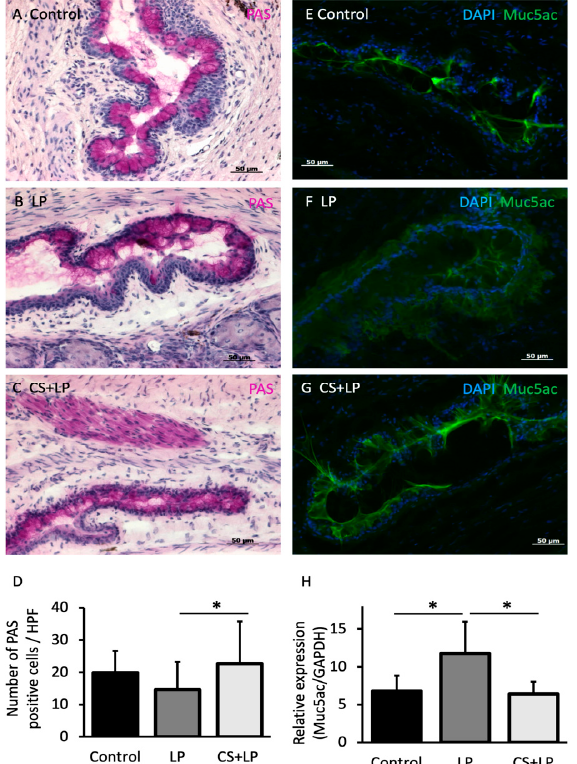
Figure 3. Conjunctival goblet cell periodic acid–Schiff (PAS) staining, muc5 immunohistochemistry staining, goblet cell density, and real time RT-PCR conjunctival muc5 mRNA expression comparisons. ( A – C ) Note the abundance of plump oval pink-purple goblet cells in the conjunctival epithelium in Group 1 (no treatment group) and Group 3, and the comparably scarce PAS positive goblet cells in Group 2 (Latanoprost group). ( D ) Note the significantly lower mean goblet cell density in the LP group compared with the CS + LP group ( p < 0.01). ( E – G ) Note the intense staining for muc5 in the conjunctival epithelium in Group 1 (no treatment) and Group 3 (CS + LP) and the comparably less intense staining in Group 2 (LP). ( H ) Note the significantly increased muc5 mRNA expression in Group 2 (LP group) compared with Group 3 (CS + LP group) and Group 1 (no treatment group) ( p = 0.011 and p = 0.0043, respectively). * represents p <